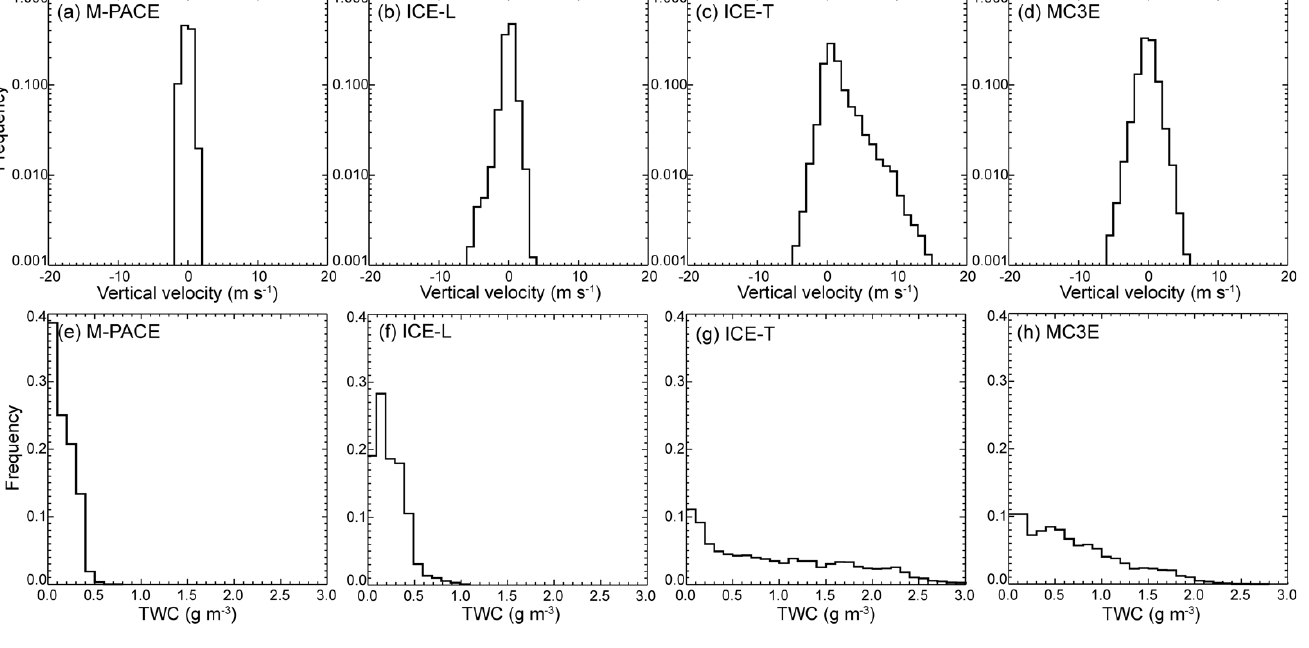
Figure 3. Frequency distributions of vertical velocity and TWC sampled in M-PACE, ICE-L, ICE-T, and MC3E, respectively.